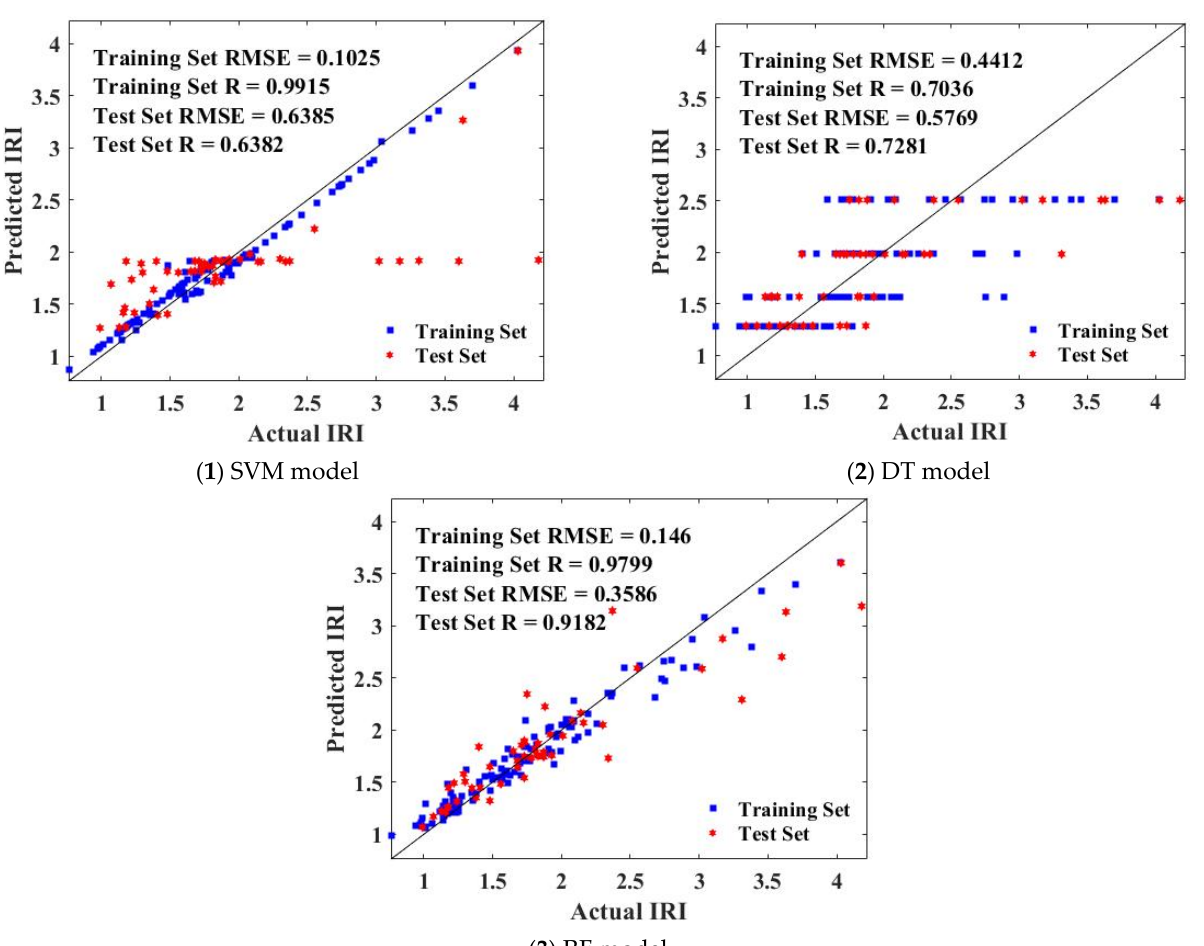
Figure 7. The comparison between the predicted value and the actual value of the SVM, DT, and RF.